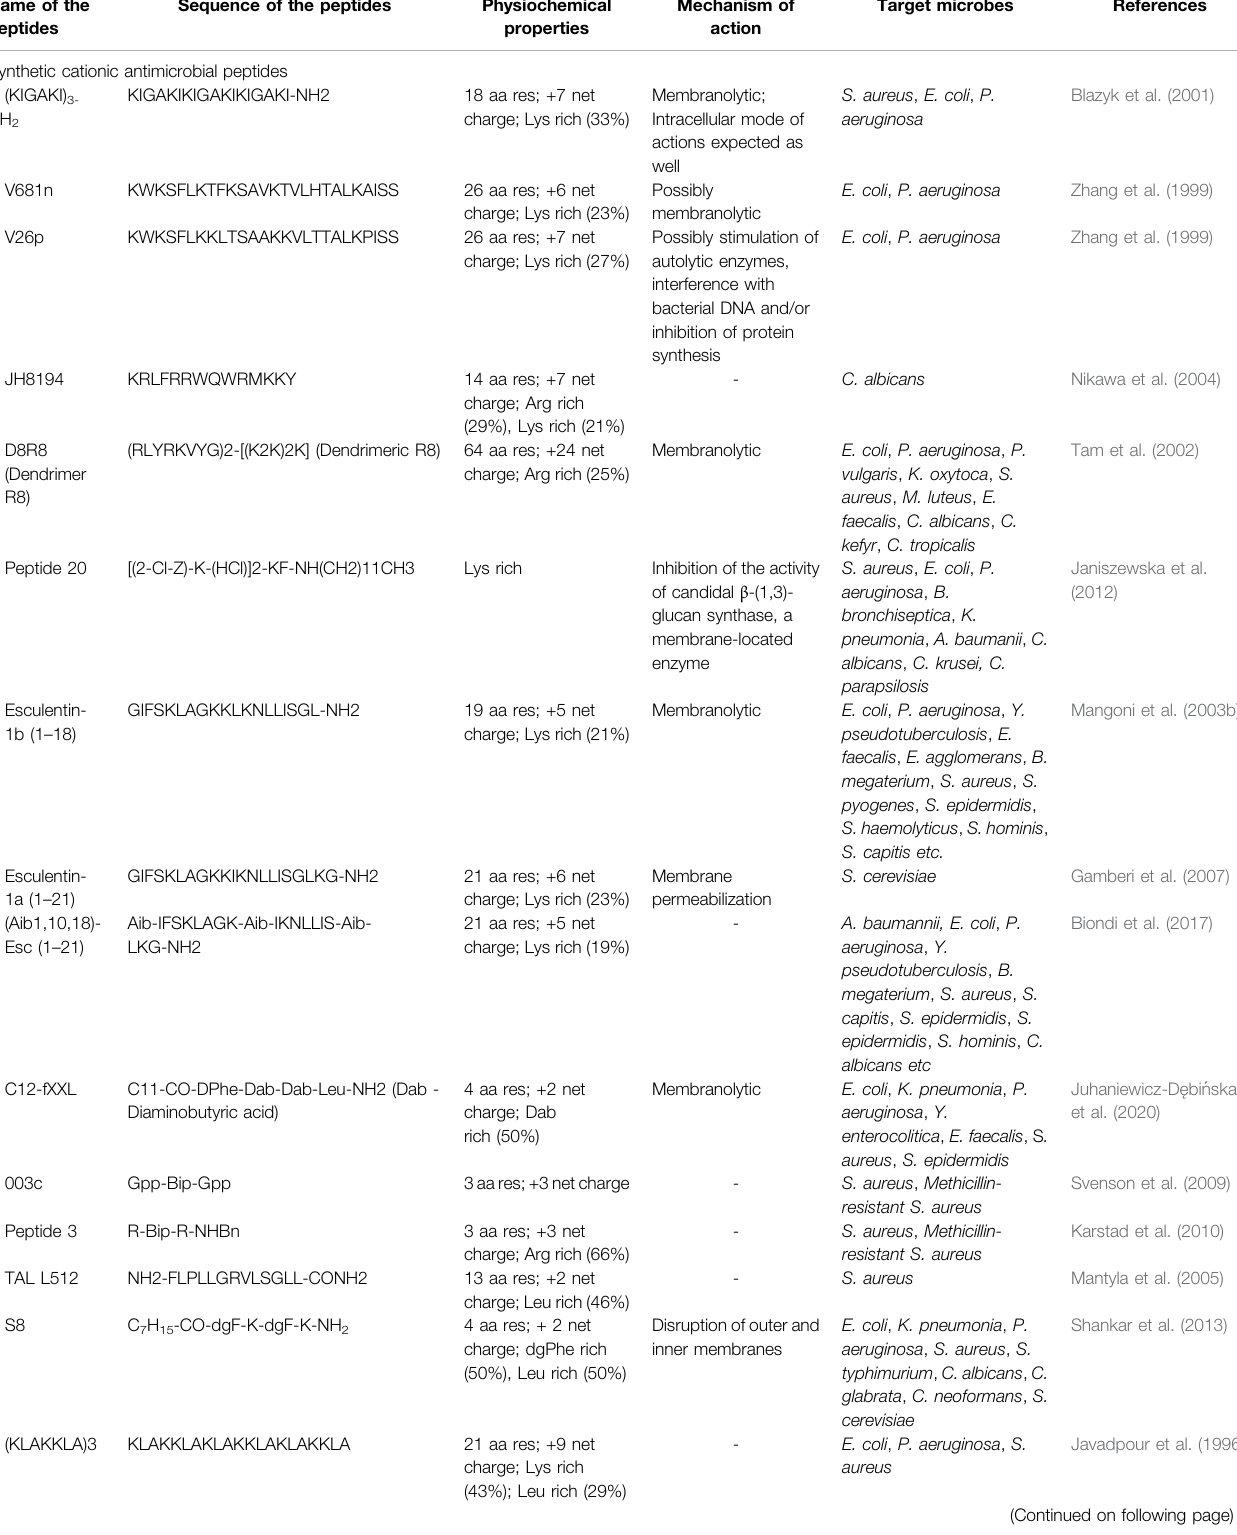
TABLE 2 | Synthetic antimicrobial peptides (aa (cid:1) amino acid, res (cid:1) residues). Name of the